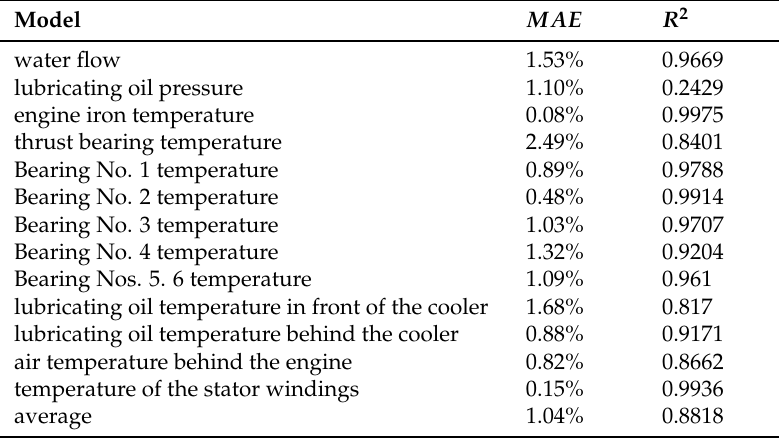
Table 3. Accuracy of each model for linear